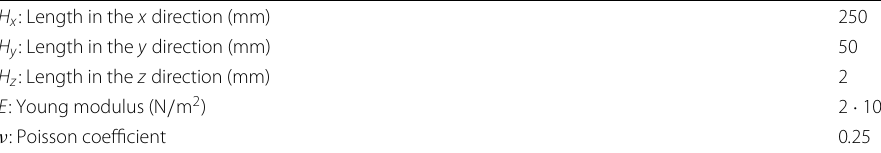
Fig. 5 Elastic problem defined in a plate domain Table 1 Problem parameters